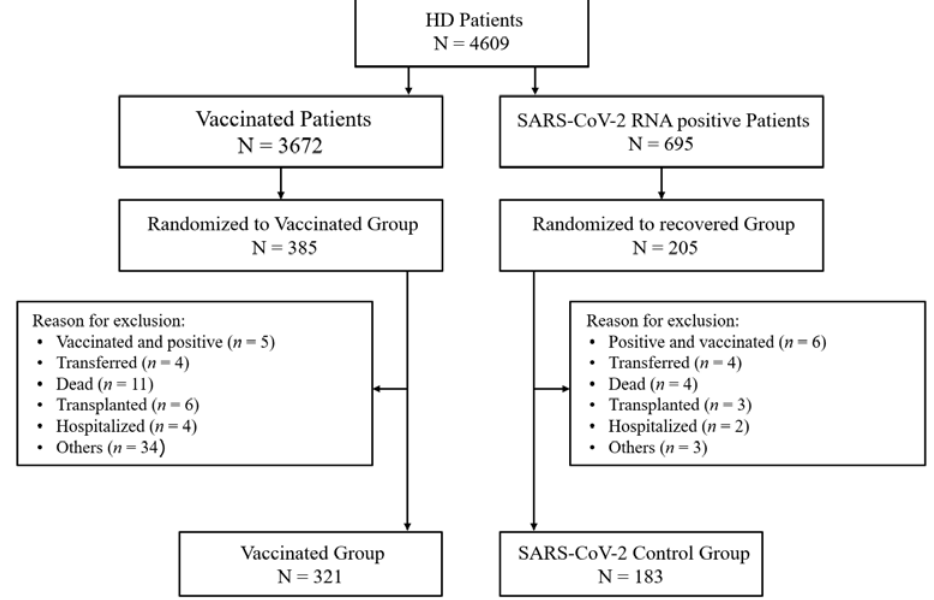
Figure 1. Patient flow diagram shows enrollment, randomization, and follow-up of study patients.